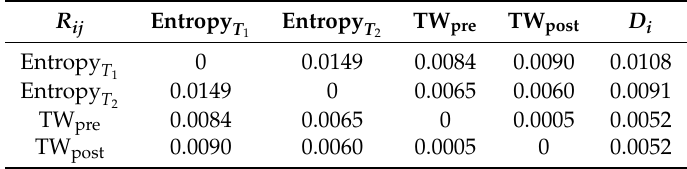
Table 3. The degree of dispersion of di ff erent weighting